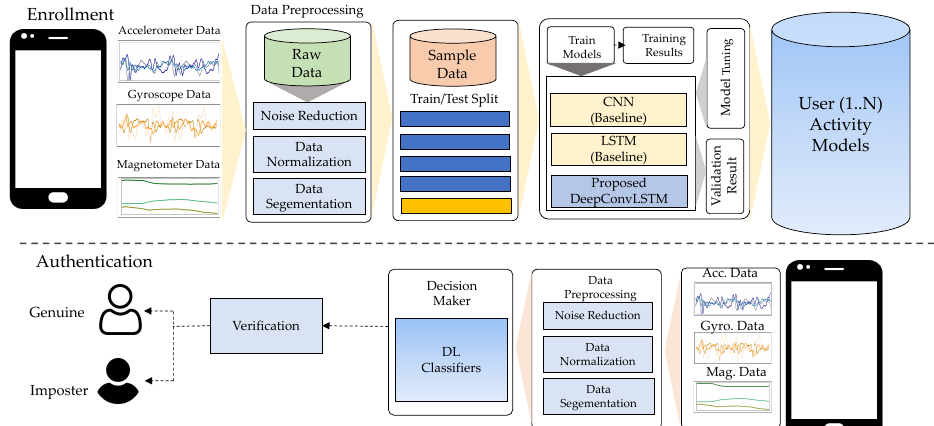
Figure 1. The overview of the DeepAuthen